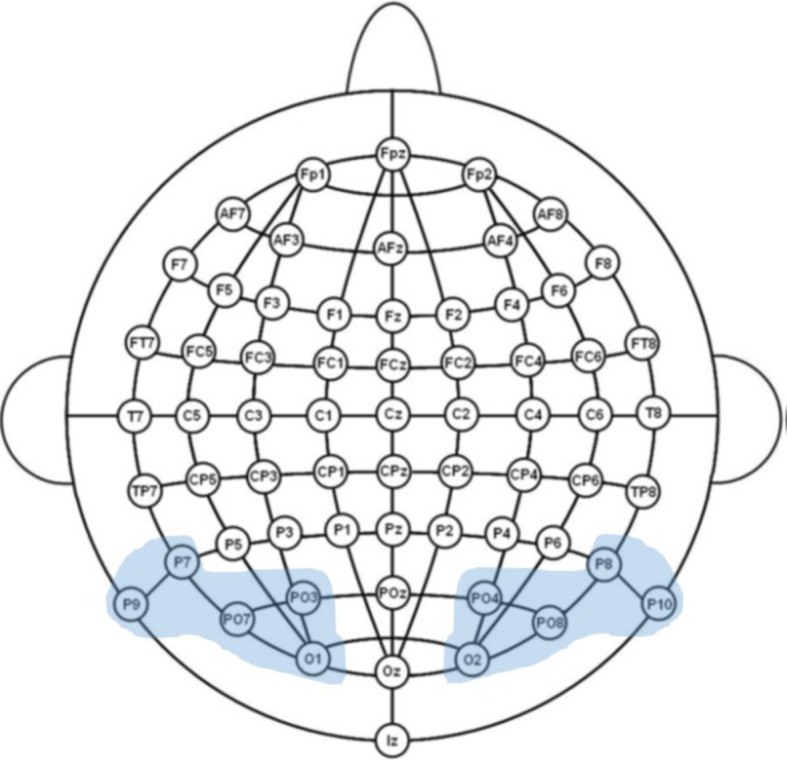
Illustration of the 64-channel system used in the experiment and the examined regions of interest.